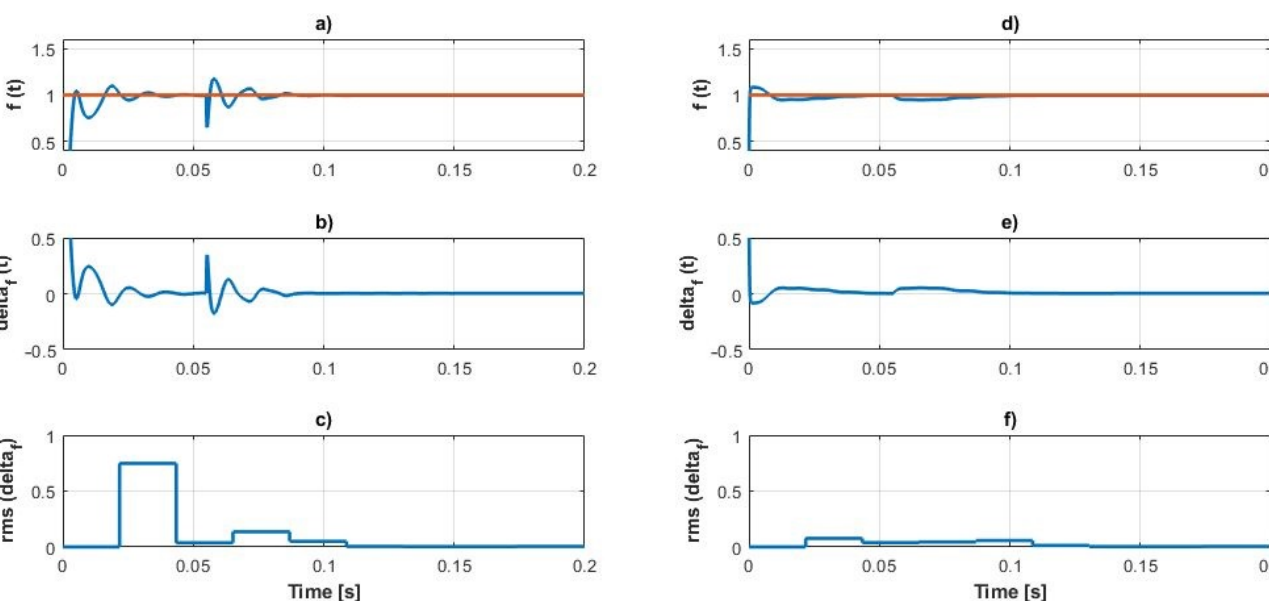
Figure 13. The L2 line short circuit to neutral wire.